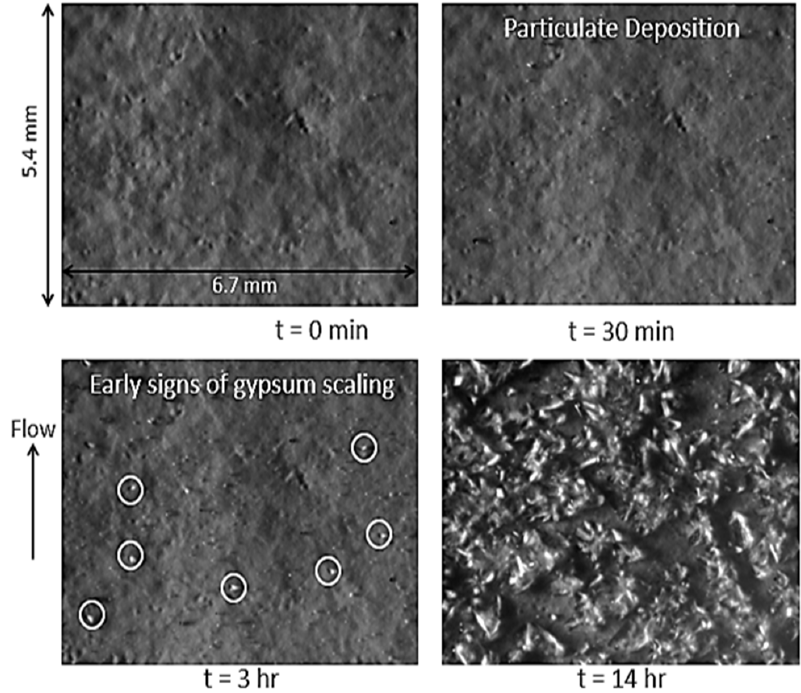
Figure 5. Real-time membrane monitoring system (MMS) surface images during desalination RO feed water treated via a filtration train without UF (configuration A). PFRO operating conditions: crossflow velocity = 4.5 cm/s, initial permeate flux = 33 L/m 2 -hr (19 gallons/ft 2 -day), and SI g,m = 1.9–2.0 corresponding to equivalent RO plant recovery of 63%.